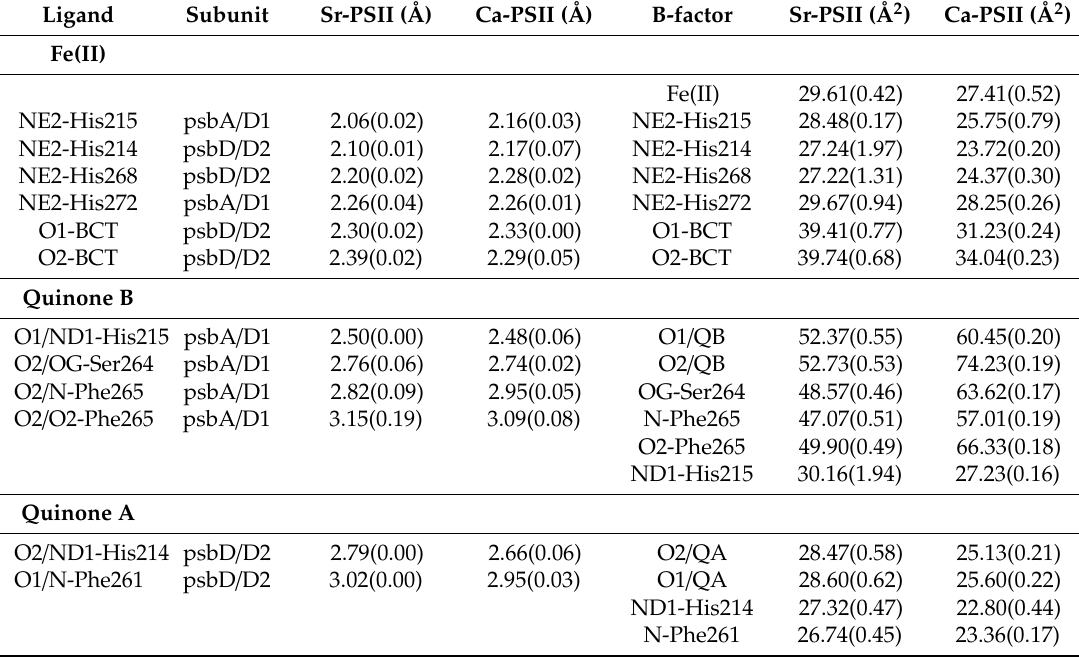
Table 1. The average interatomic distances of the acceptor site of Sr-PSII (PDB: 4IL6) and native Ca-PSII (PDB: 3Wu2) and their corresponding temperature